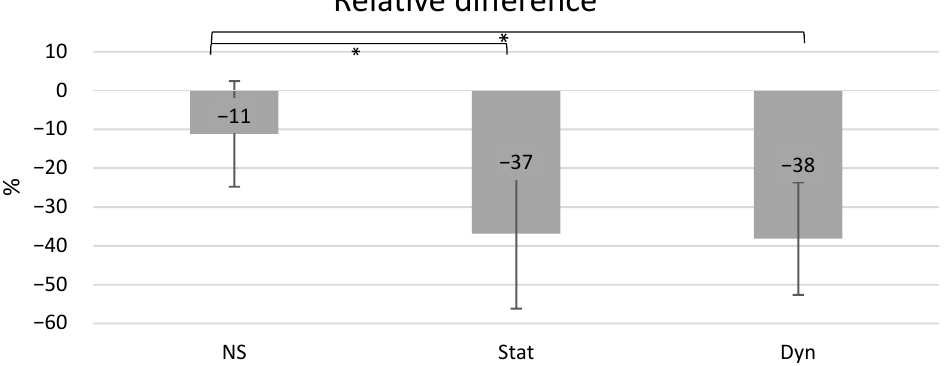
Figure 4. Averaged value of the stiffness relative differences for the NS (Non-seeded), Stat (static condition), and Dyn (dynamic conditions) obtained by analyzing nine samples (three matrices and three experimental campaigns) between d 10 and d 21. *: significantly different (p-value < 0.05).